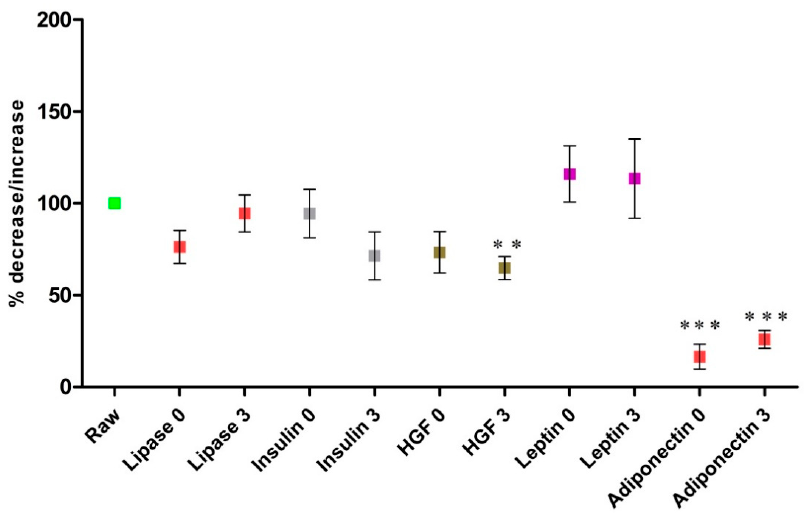
Figure 3. Changes in mean concentrations of leptin, adiponectin, hepatocyte growth factor (HGF), insulin, and lipase in human milk after the HPP + Lyo processes and 3-month storage compared with raw human milk. The data are presented as mean values with the standard error of the mean. The percentage of concentrations of the selected bioactive components in milk samples subjected to HPP + Lyo at time 0 (0) and at 3 months (3) compared to raw human milk (100%) (3). Statistically significant differences were observed and marked with asterisks, depending on the degree of significance (*** p < 0.0001, ** p < 0.001), only adiponectin (at time 0, p = 0.0002; at month 3, p < 0.0001) and HGF (at month 3, p = 0.0049). The differences in leptin, insulin, and lipase levels measured in treated (HPP + Lyo) milk samples stored for 3 months and in raw milk samples were not statistically significant ( p > 0.05). Table 1. Log bacterial growth in pooled human milk samples inoculated with bacterial strains, treated with pascalization or a combination of pascalization, and subjected to freeze-drying at time 0 and at 3 and 6 months of storage.